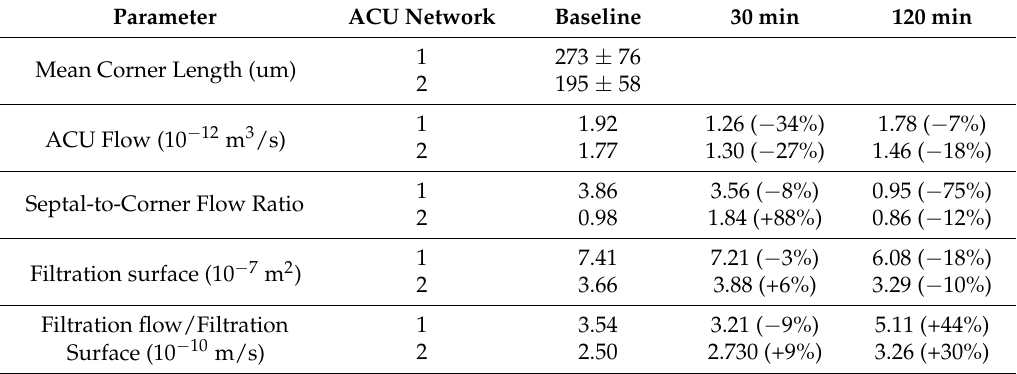
Figure 7. Results of perfusion analysis for two different ACU regions. Red and light blue dots identify respectively arteriolar accesses and venular exits. The color panels show ACU capillary blood flow at different time points (baseline, 30, and 120 min of hypoxia exposure) with color-coded log-scale intensity. Table 2. This table illustrates the main topological and fluid-dynamic parameters for the modeled ACU networks.